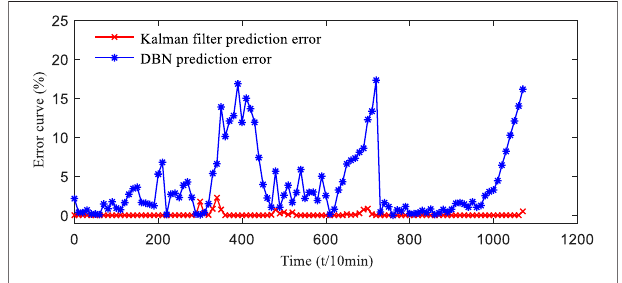
FIGURE 11 | Comparison curve of Kalman fi lter and DBN prediction